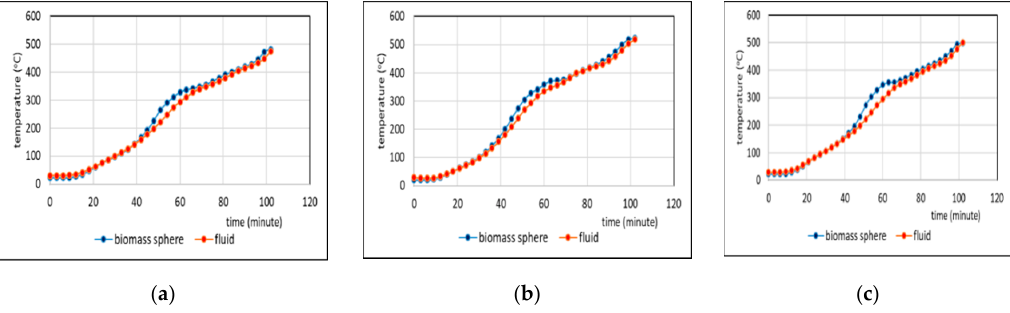
Figure 4. Comparison of temperatures of biomass spheres and co-pyrolysis fluid taken at thermocouple #3 ( a ), thermocouple #4 ( b ), thermocouple #5 ( c ). Co-pyrolysis used a feed containing 25% weight of PP.